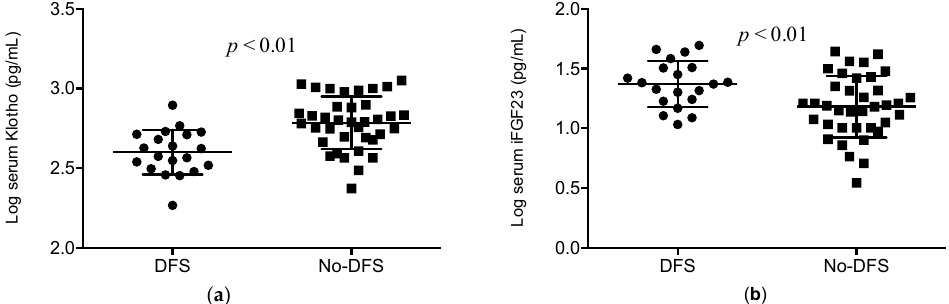
Figure 1. Differences in the log-transformed blood levels of ( a ) Klotho and ( b ) FGF23 between patients with and without diabetic foot syndrome